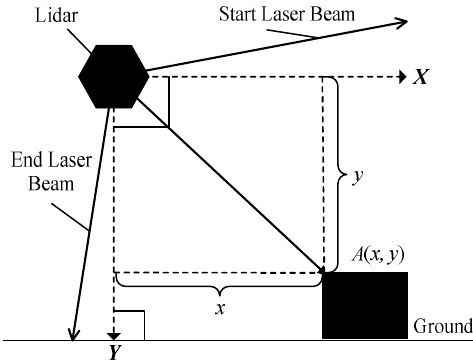
Figure 4. The coordinate system of a lidar and coordinate transformation.